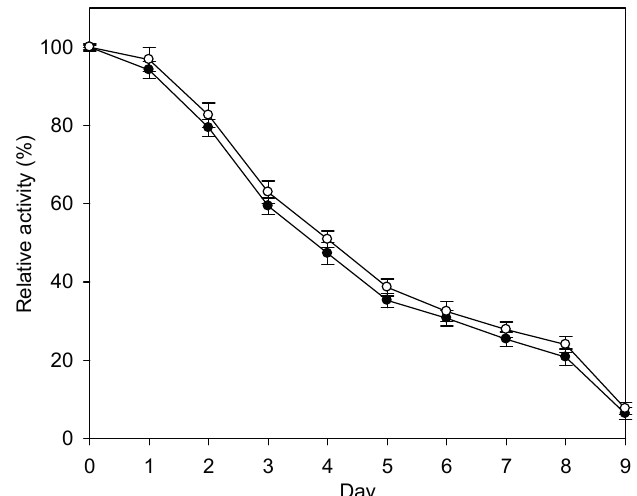
Figure 6. Batchwise reactions of immobilized enzyme at 45 °C. Fe 3 O 4 -CS- or Fe 3 O 4 -CS-THP-immobilized enzymes (0.5 g) was added to 50 mL of 36% (w·v − 1 ) lactose at pH 6.0 in a 500 mL Erlenmeyer flask. The solution was incubated 45 °C on an orbital shaker bath of 200 rpm and the lactose solution was replaced every 24 h. The immobilized enzyme was recovered everyday by applying a magnetic field and the residual activity was measured by the standard assay. The procedure was repeated for 9 days. The activity at beginning of the experiments was set as 100%. The data are averaged from three